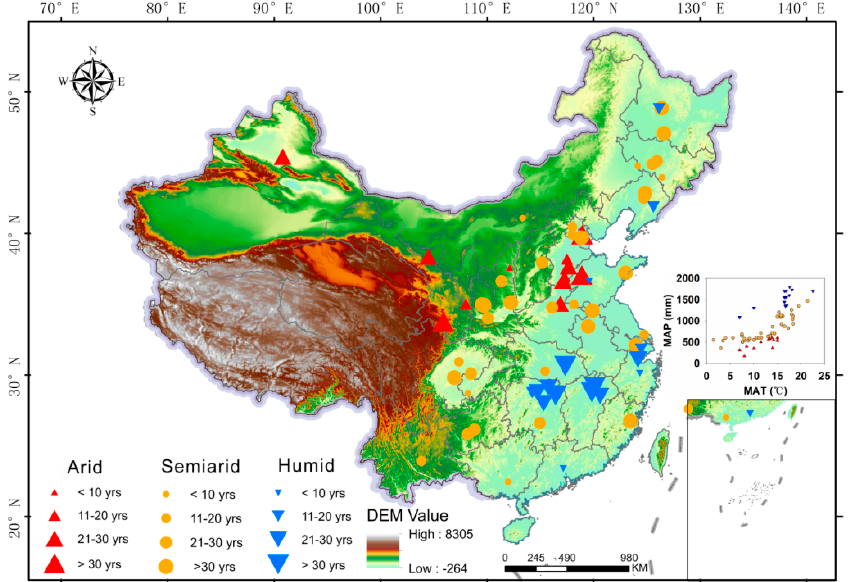
Figure 1. Sixty − seven long-term fertilization experimental stations in China, presented according to HIs (humidity index) (HI = MAP/(MAT + 10)) and cultivation duration (triangle: HI ≤ 25, circle: 25 < HI < 50, inverted triangle: HI ≥ 50). The size of symbols corresponds the cultivation duration. The digital elevation model (DEM) is a digital simulation of the terrain using limited terrain elevation data. MAT represents the mean annual temperature; MAP represents the mean annual precipita- tion. The MAT − MAP inset shows the climatic conditions of the 67 study sites. The county map is based on the standard map released by Ministry of Natural Resources of the People’s Republic of China (No. GS(2019)1822).